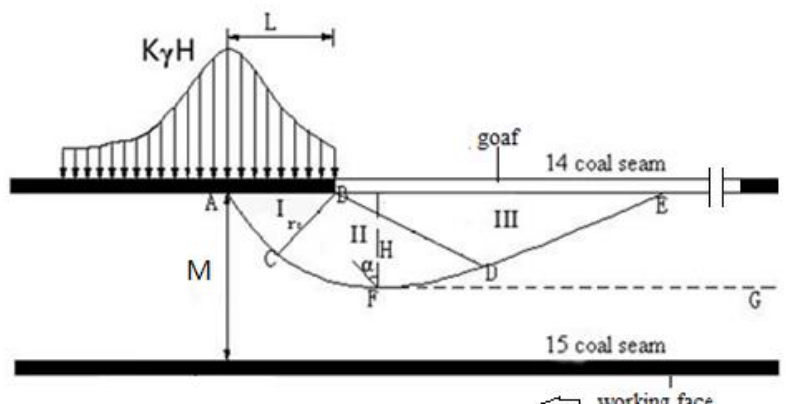
Figure 2. Theoretical model of floor failure in coal seam stoping.